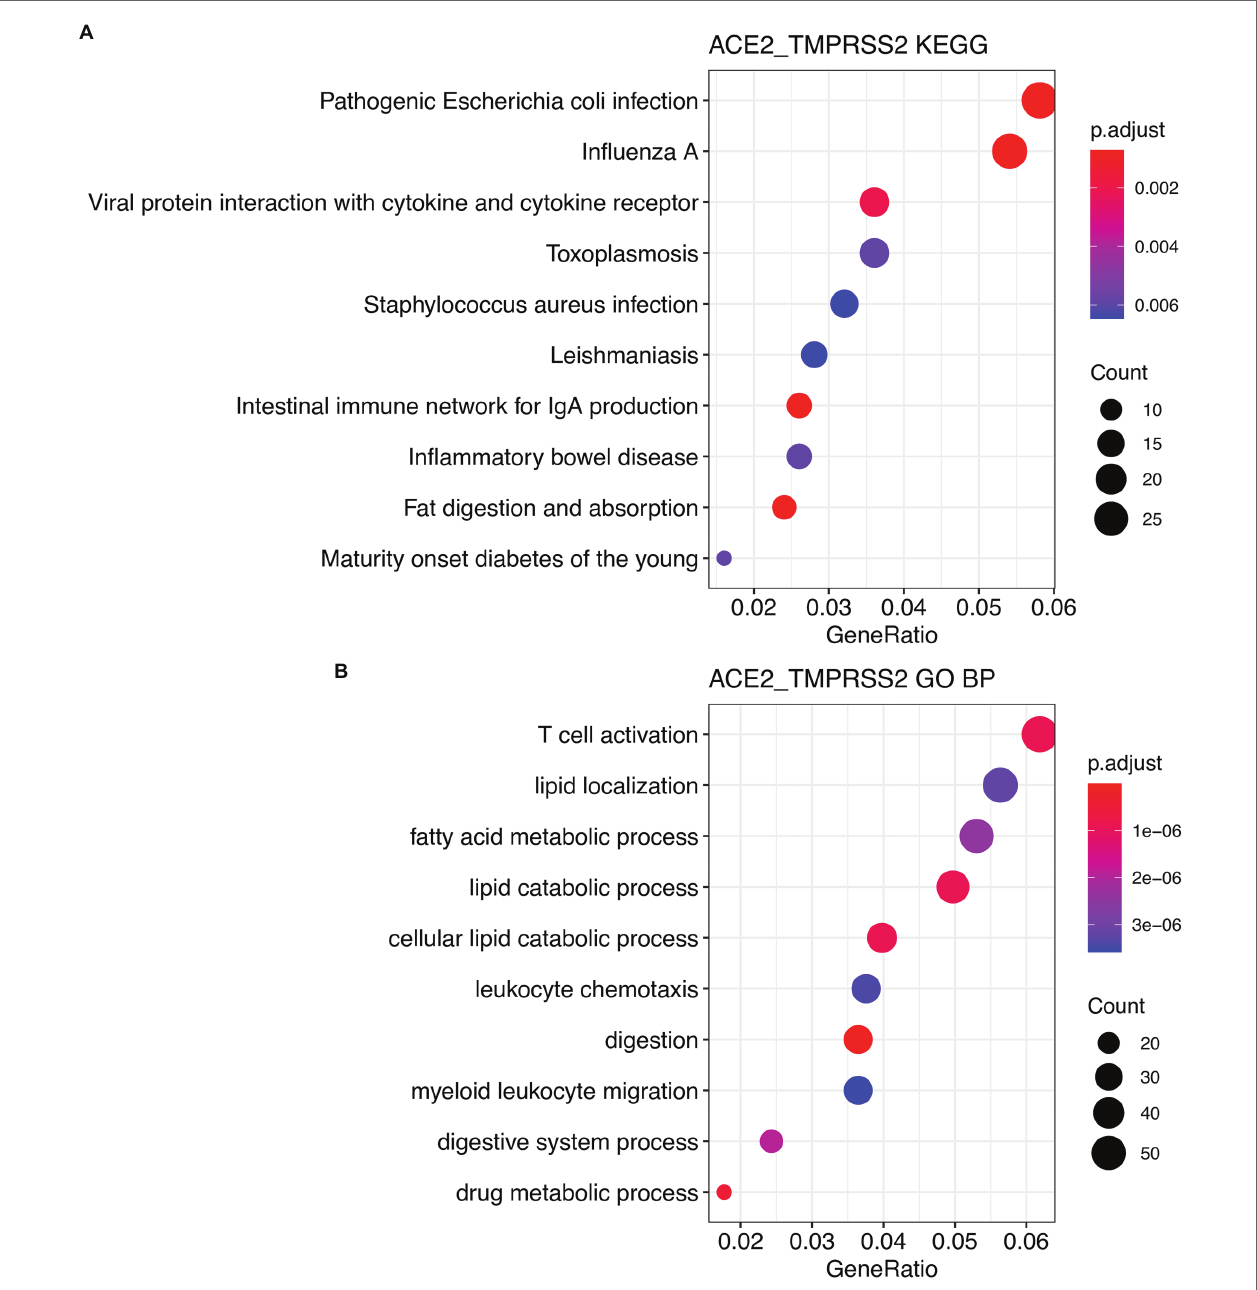
FIGURE 7 | Enrichment analysis of genes of the brown module. Kyoto Encyclopedia of Genes and Genomes pathway (A) and biological process analysis results (B) of high relationship genes in intestine vs. brown module. One thousand thirty one genes (genes with MM > 0.79 and GS > 0.24) were used for enrichment